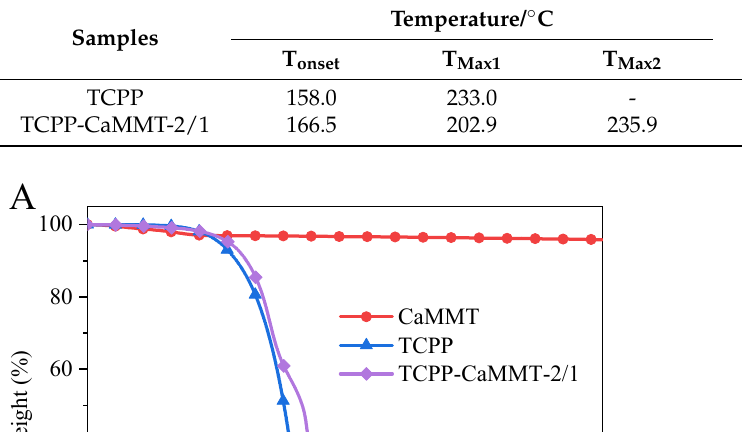
Table 4. Thermogravimetric data of TCPP-CaMMT-2/1 in N 2 .